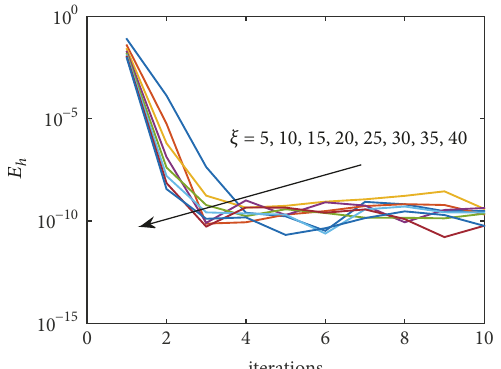
Figure 8: Convergence error graph of ℎ(𝜁,𝜉) at different values of 𝜁 , 𝑁 𝜂 = 60 , 𝑁 𝜁 = 5 , 𝑛 = 𝑤 = 1/2 , 𝑃𝑟 = 0.7 , 𝑆𝑐 = 0.6 , and 𝑧 = 40